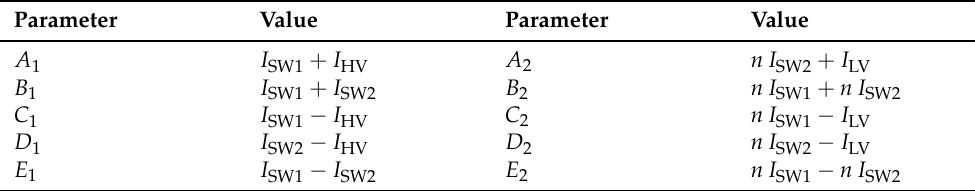
Table 2. Definition of key parameters for the simplification of the analytical models of this work (see Appendix